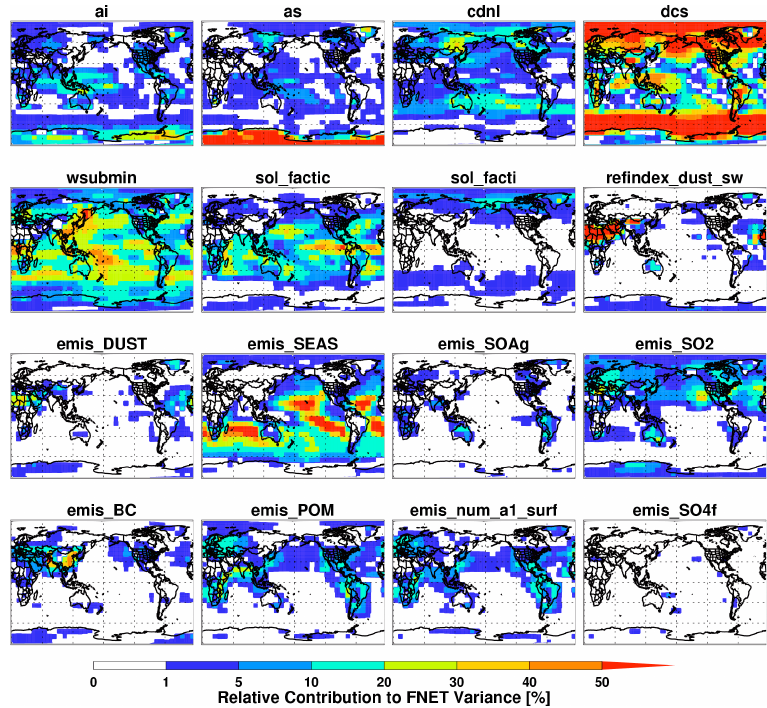
Figure 9 Global spatial distribution of percentage of FNET variance in response to the 1099 Fig. 9. Global spatial distribution of percentage of FNET variance in response to the perturbation of each of the 16 input parameters predicted by the perturbation of each of the 16 input parameters predicted by the GLM. 1100